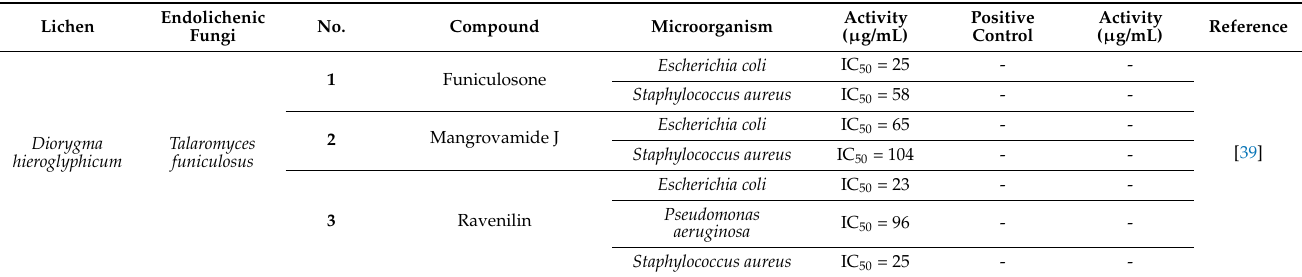
Table 1. Antimicrobial Compounds Isolated from